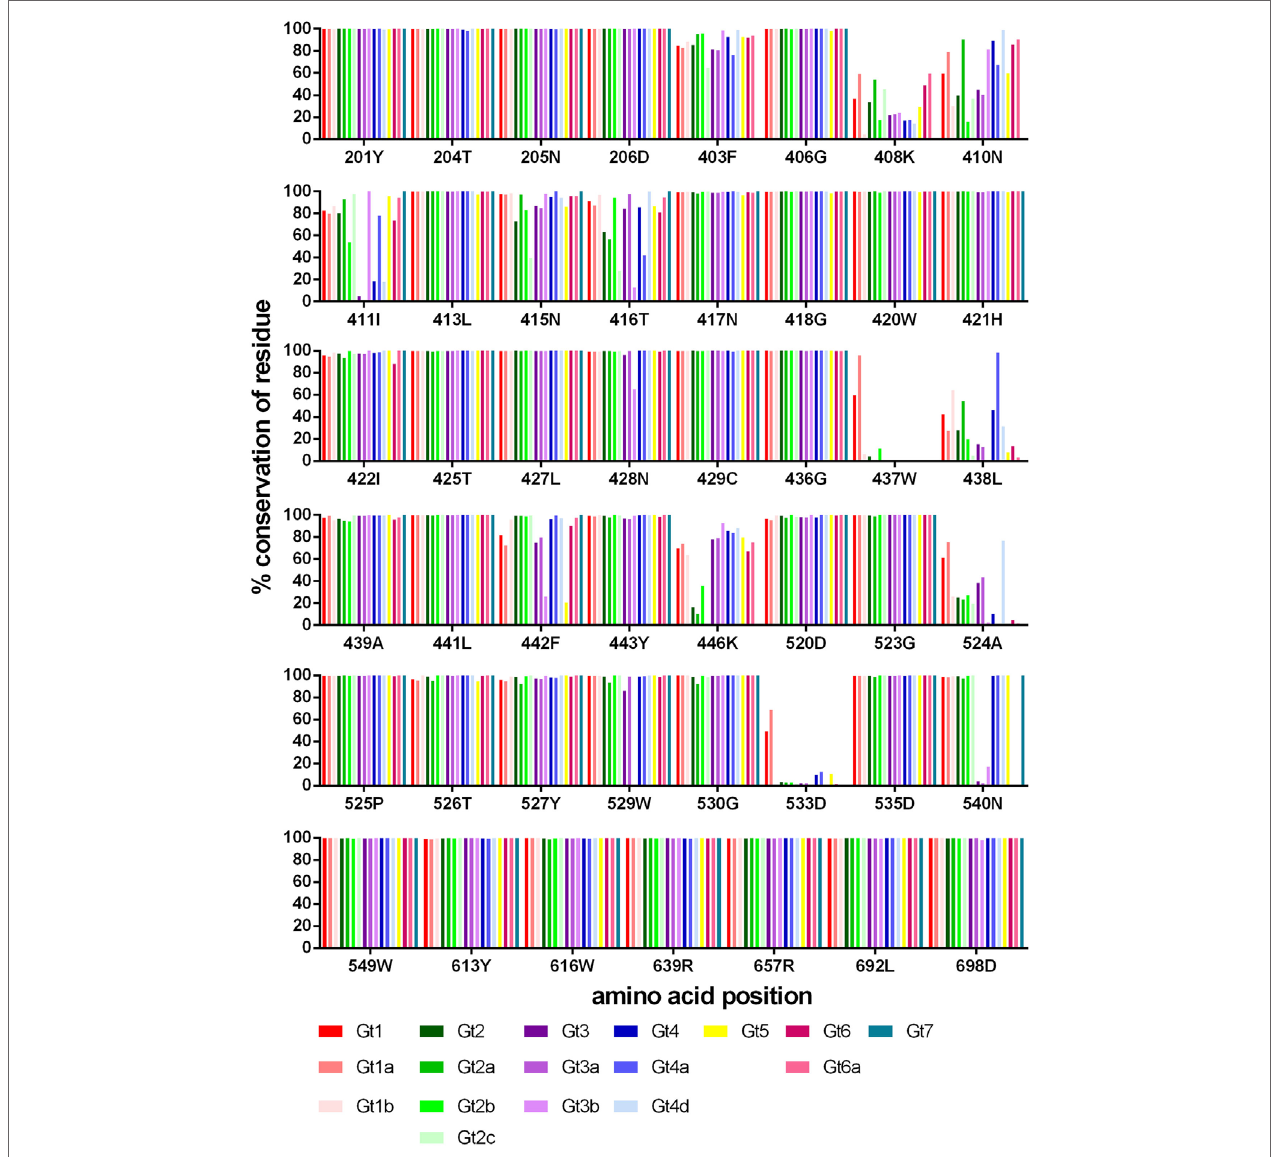
FigUre 3 | Conservation of bNAb-bound residues. The level of conservation (%) with respect to the reference sequence is shown for each genotype and subtype. Gt1 (red), Gt2 (green), Gt3 (purple), Gt4 (blue), Gt5 (yellow), Gt6 (pink), and Gt7